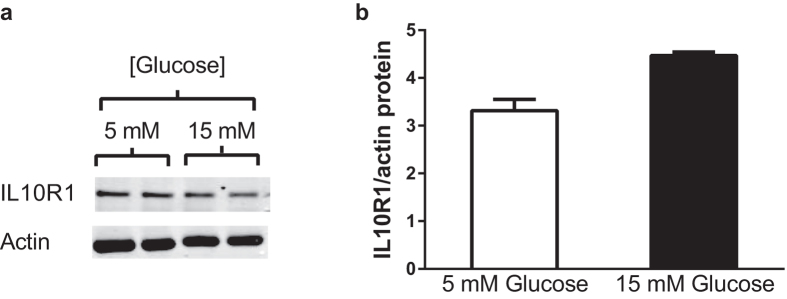
Protein levels of IL10R1 in macrophages are not affected by altered glucose levels.(a) Cell lysates from RAW264.7 cells cultured in 5 mM or 15 mM glucose for six hours were immunoblotted with the indicated Abs. Representative immunoblots from duplicates are shown. (b) Band intensities were quantified on a Li-Cor Odyssey scanner and normalized to the levels of actin and plotted in the bar graph. Paired t-tests revealed no significant differences between 5 mM and 15 mM glucose. Values are mean ± SEM (N = 3). P > 0.05.